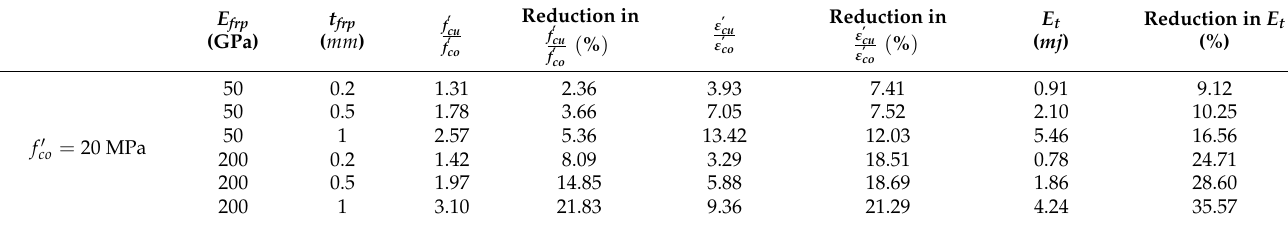
Table A3. FEM results for θ = 8 ◦